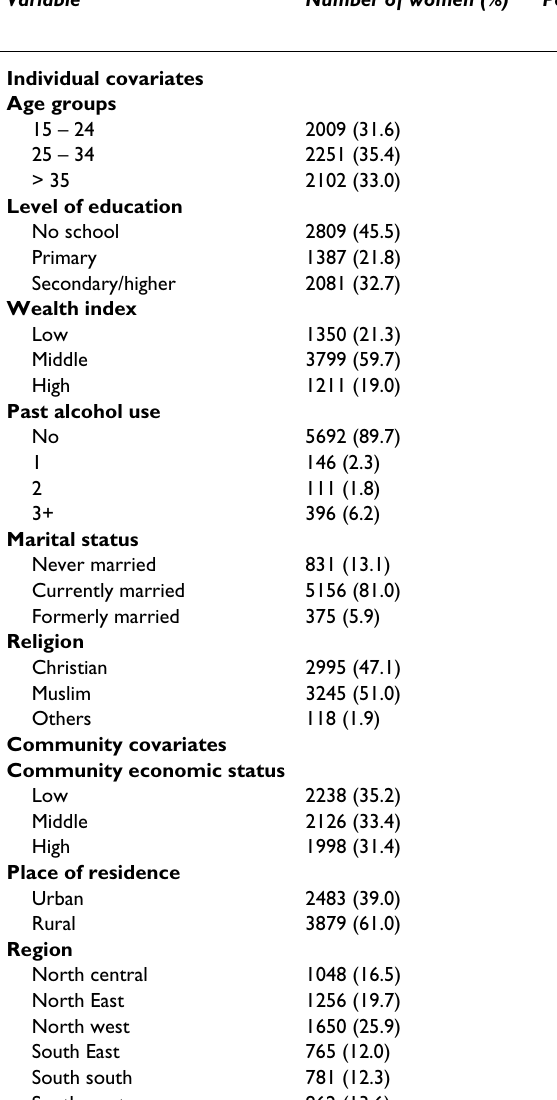
Table 1: Socio-demographic characteristics of sexually active Nigeria women who participated in the study, 2003